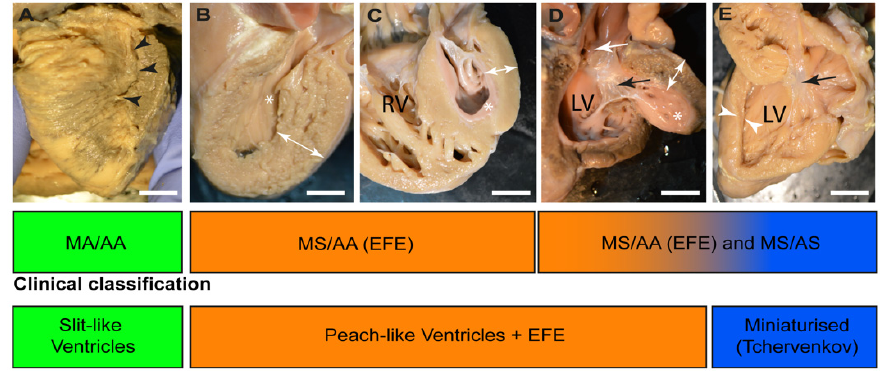
Figure 1. Clinical and morphological classifications of HLHS. ( A ) mitral atresia and aortic atresia (AA/MA). The posterior surface of the ventricular mass has been shaved to reveal a slit-like ventricu- lar cavity phenotype (black arrow heads) without gross evidence of endocardial fibroelastosis (EFE). The apex of the heart is formed by the right ventricle. ( B ) Free left ventricular wall of a heart with mitral stenosis/aortic atresia (MS/AA). There is endocardial fibroelastosis seen on the inner surface of the left ventricular cavity (*) and the left ventricular wall is thickened (white double arrow). ( C ) Further example of MS/AA with thickened left ventricular wall (double white arrow) and